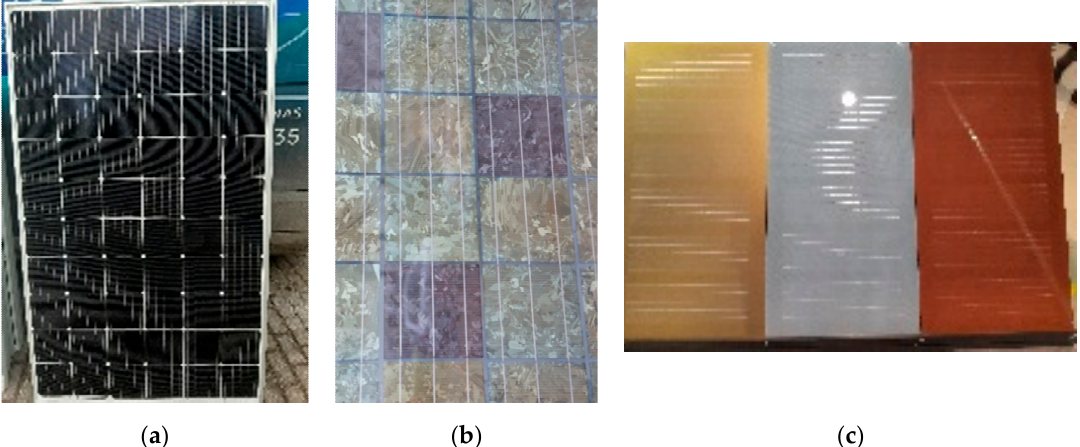
Figure 1. Photovoltaic panels: ( a ) monocrystalline, ( b ) polycrystalline, ( c ) dye-sensitized colored cell (photo by Celadyn, W.).